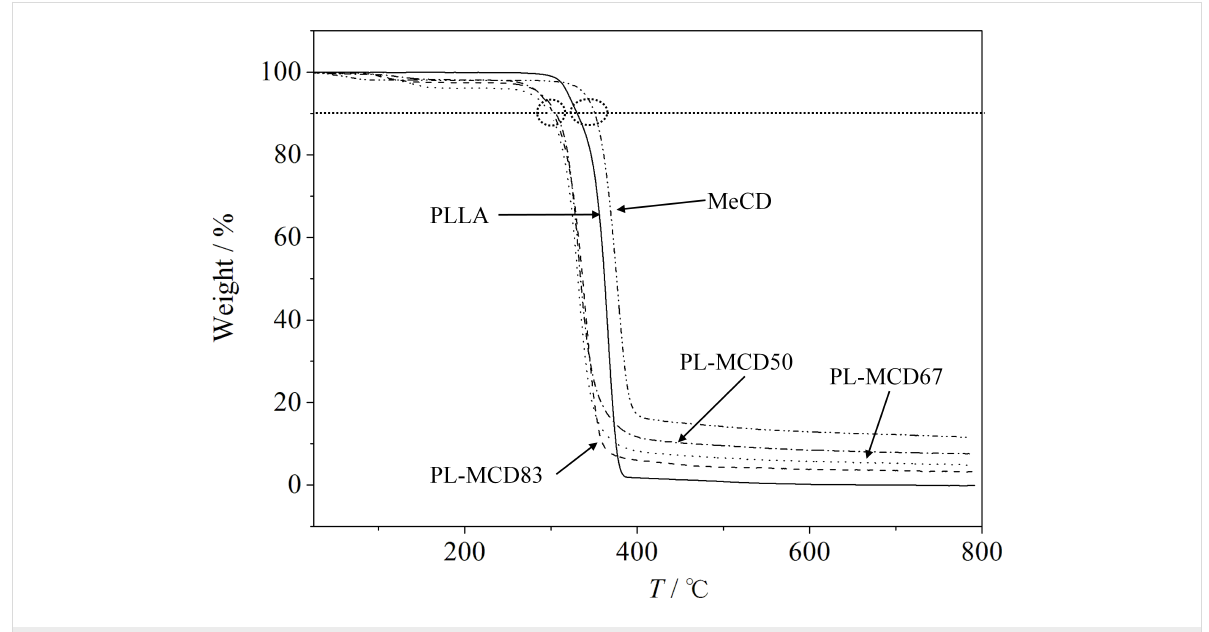
Figure 1: Thermo-gravitometry for PLLA, PL-MCD83, PL-MCD67, PL-MCD50 and